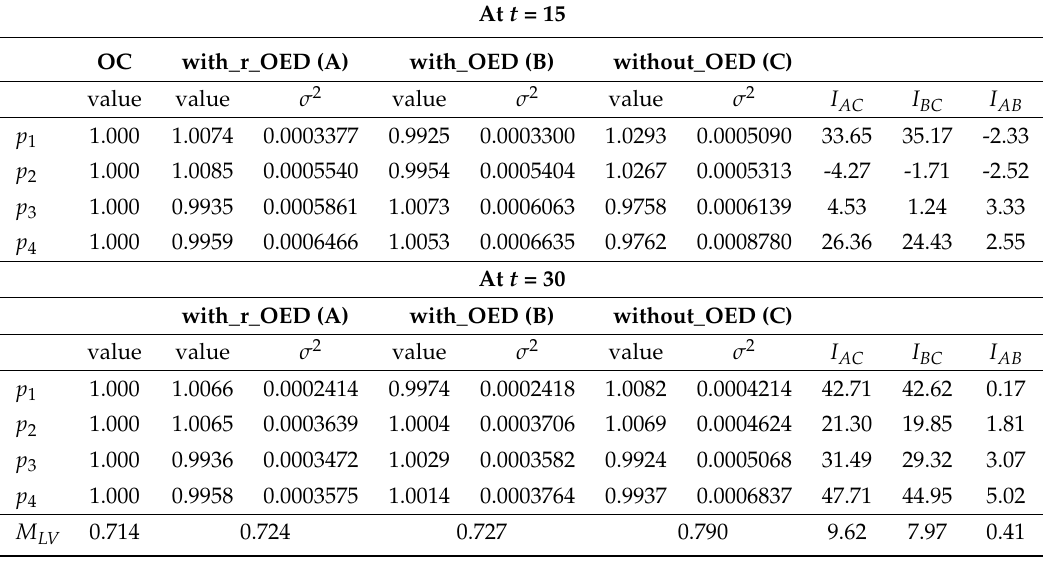
Table 1. Averaged estimated parameter values with their uncertainties and the objective function Algorithm 2 ( with_ r _OED (A) , with_OED (B) , without_OED (C)). I ij ( % ) is the relative uncertainty and objective value improvement after t = 15 and t = 30 of column i compared to column j . Column